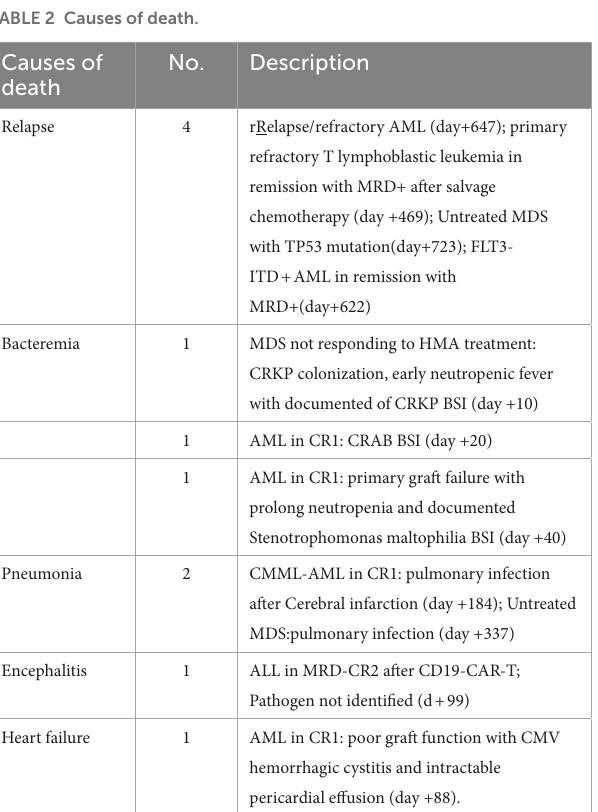
TABLE 2 Causes of